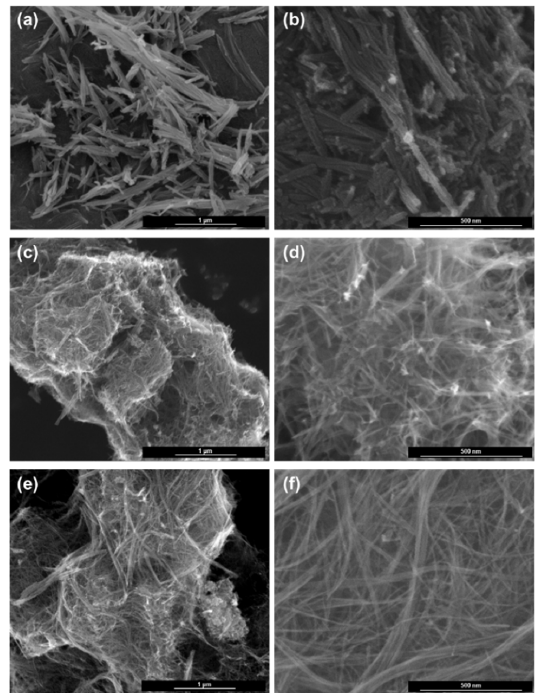
Figure 3. FE-SEM images of synthesized pure TNT nanostructures: ( a ) low and ( b ) high magnifica- tion. Mo-TNT nanostructures: ( c ) low and ( d ) high magnification. W-TNT nanostructures: ( e ) low and ( f ) high magnification.